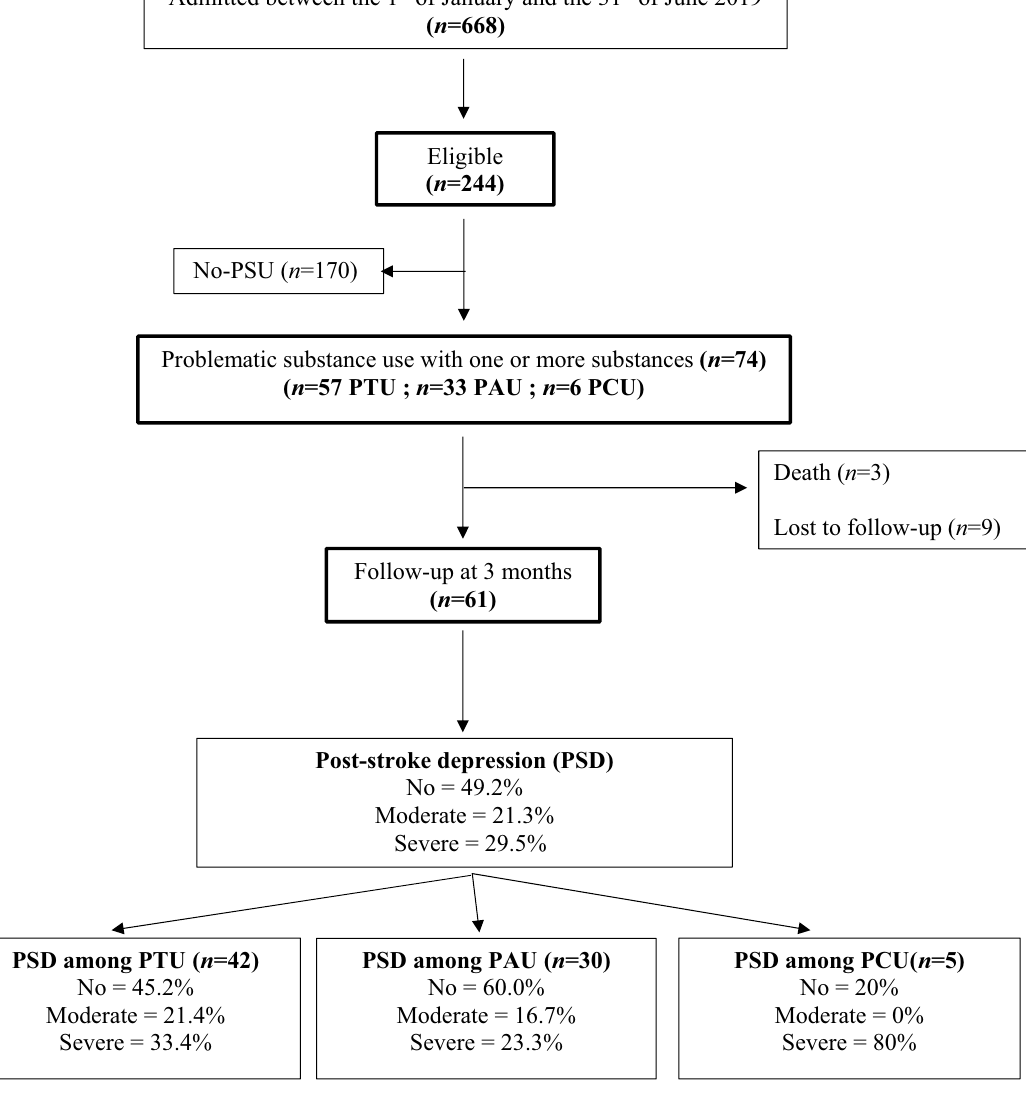
Figure 1. Study flow-chart. PAU Problematic Alcohol Users, PCU Problematic cannabis users, PSU Problematic Substance Users, PTU Problematic Tobacco